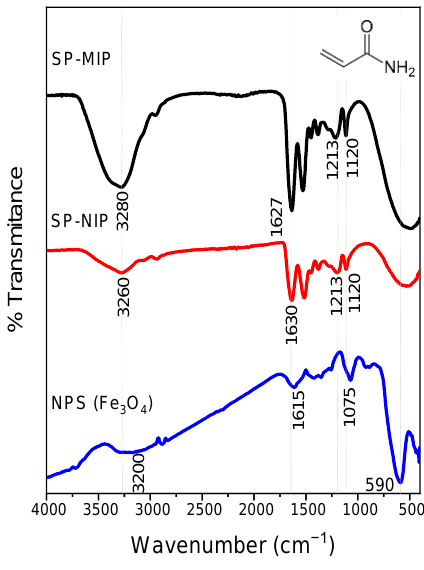
Figure 6. FTIR spectra NIP.